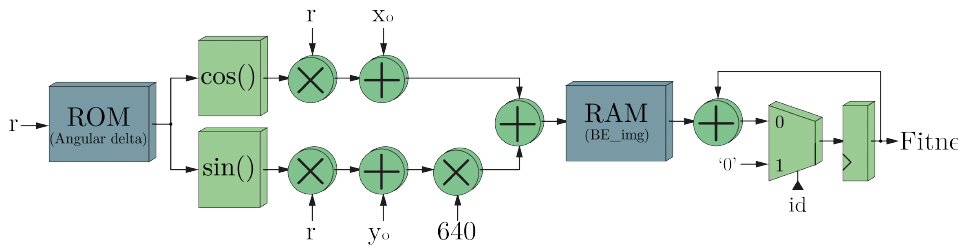
Figure 6. Block diagram for fitness evaluation.